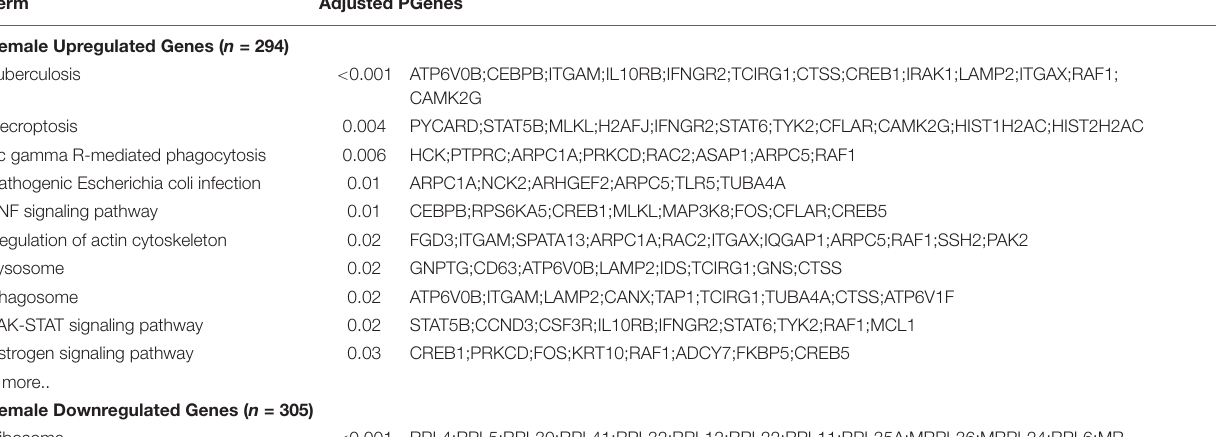
TABLE 3 | Enriched pathways in blood. Term Adjusted